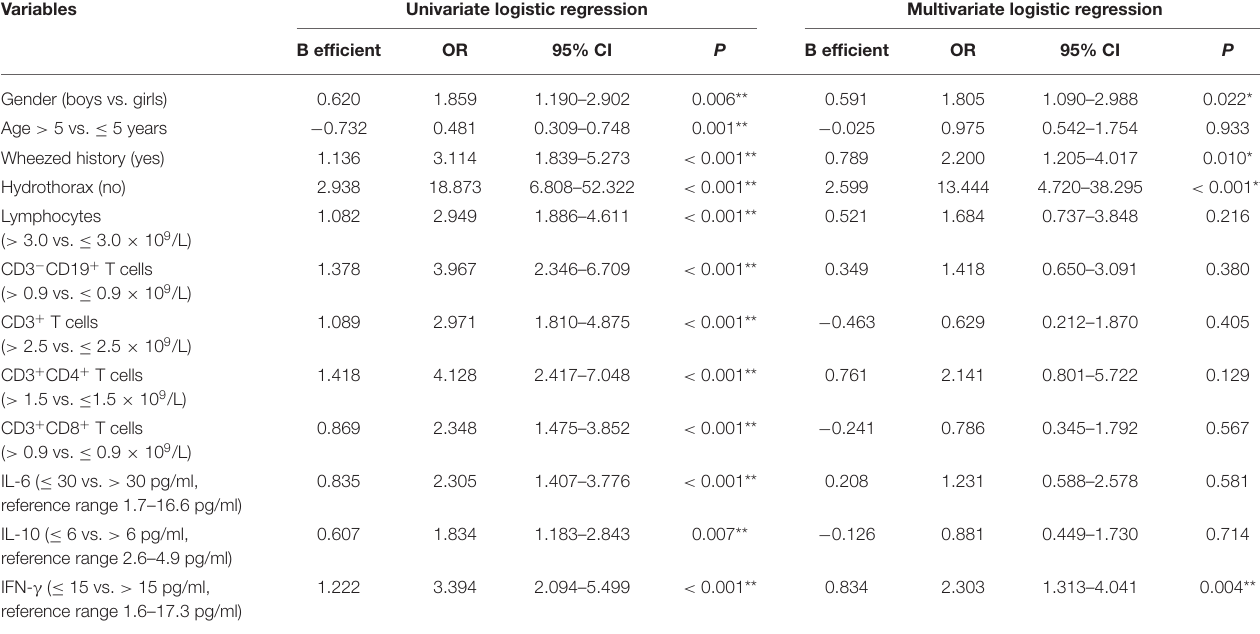
TABLE 2 | Risk factors associated with the development of IP on logistic regression analysis. Variables Univariate logistic regression Multivariate logistic regression OR 95% CI P OR 95% CI P